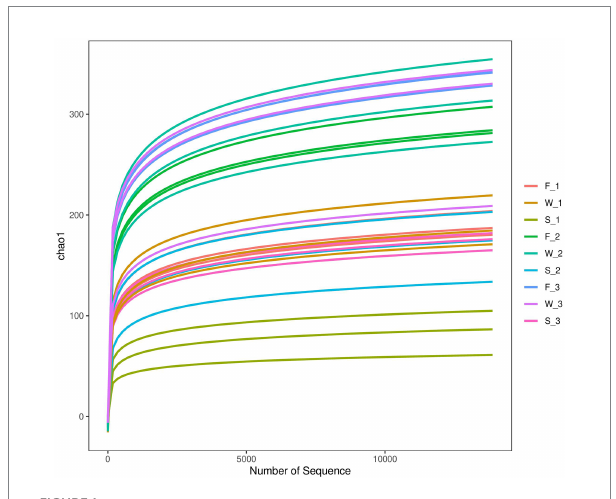
FIGURE 1 Chao1 rarefaction curve of samples for pre-ensiled crop fresh alfalfa (F), wilted alfalfa (W) and ensiled alfalfa (S) at the first cutting (F_1, W_1, and S_1), the second cutting (F_2, W_2, and S_2), or the third cutting (F_3, W_3, and